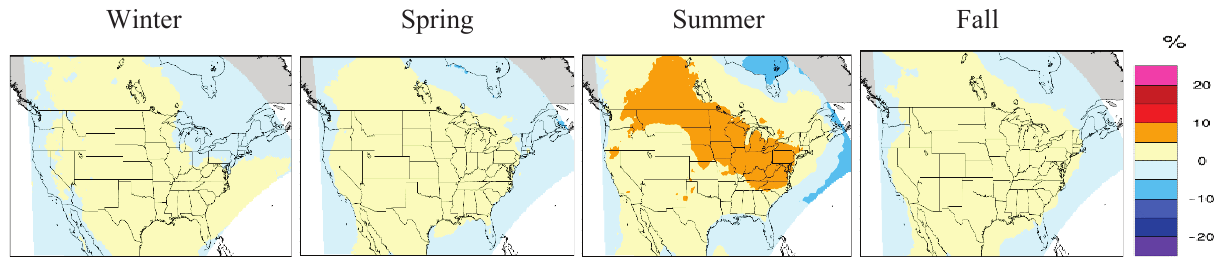
Figure 11. Differences in the seasonal averaged DM8A BC1 / BCT (%) between WRF / DEHM_noddry and WRF / DEHM (WRF / DEHM_noddry minus WRF / DEHM). The areas in white or grey are the grid cells that are out of the simulation domain of WRF /